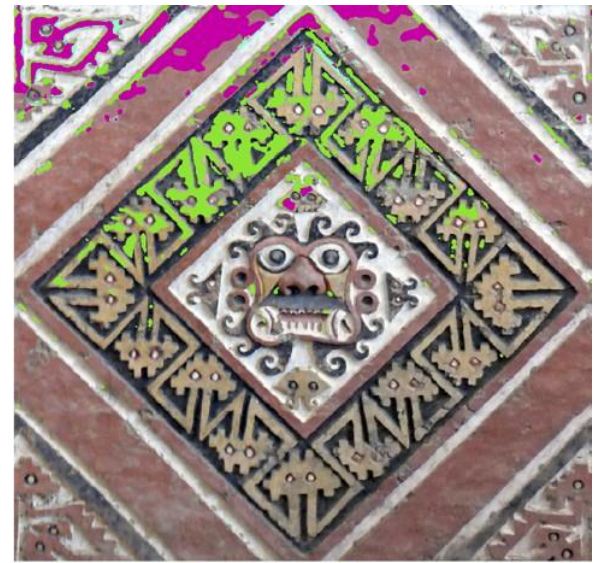
Figure 10. The Image where there are all the changes over the year. Legend: cyan is for the changes detected only in Figure 8. The clustered combined difference image between 2012; green is for the changes detected only in 2017; magenta 2006-2017 is for the changes that are in both 2012 and